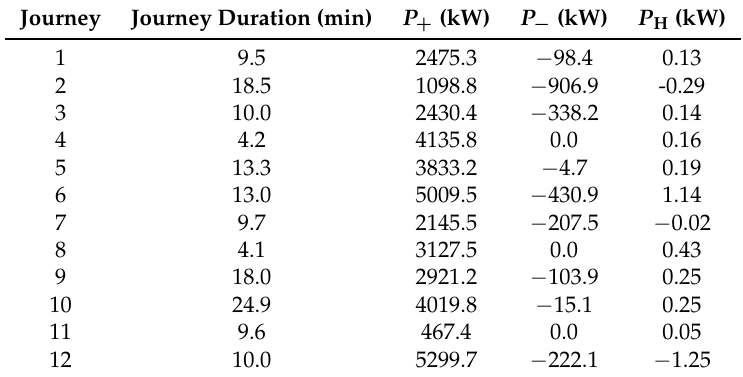
Table 3. Positive active power, negative active power and non-fundamental active